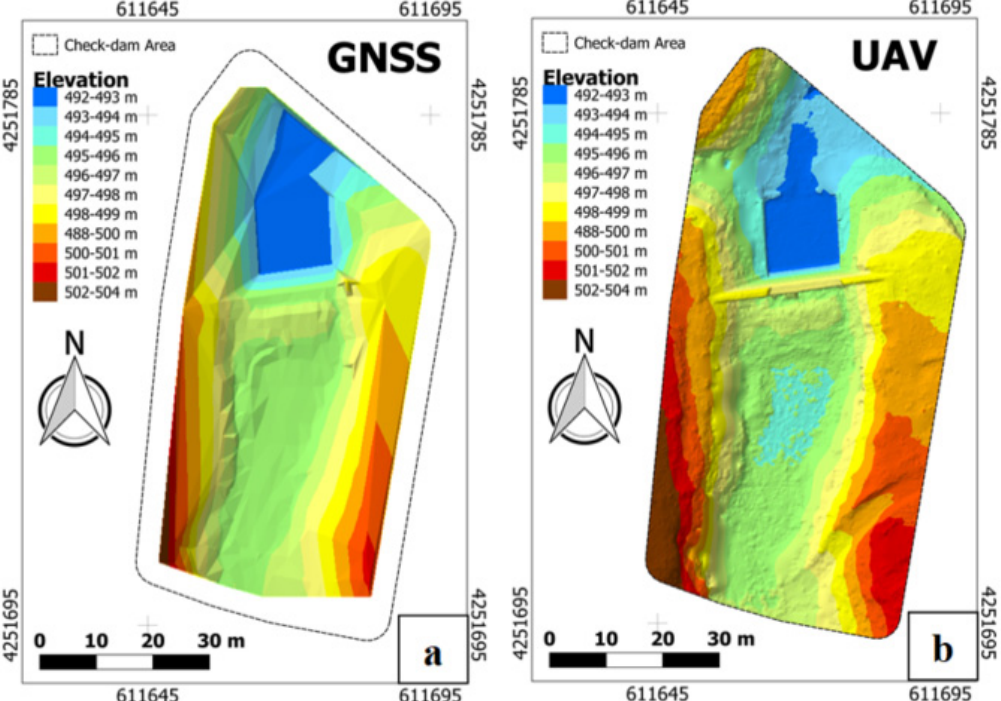
Figure 8. Digital Terrain Models (DTMs) obtained by the topographic ( a ) and aerophotogrammetric ( b ) methods for the Palomar check dam (Sierra de Los Donceles forest, Castilla La Mancha,